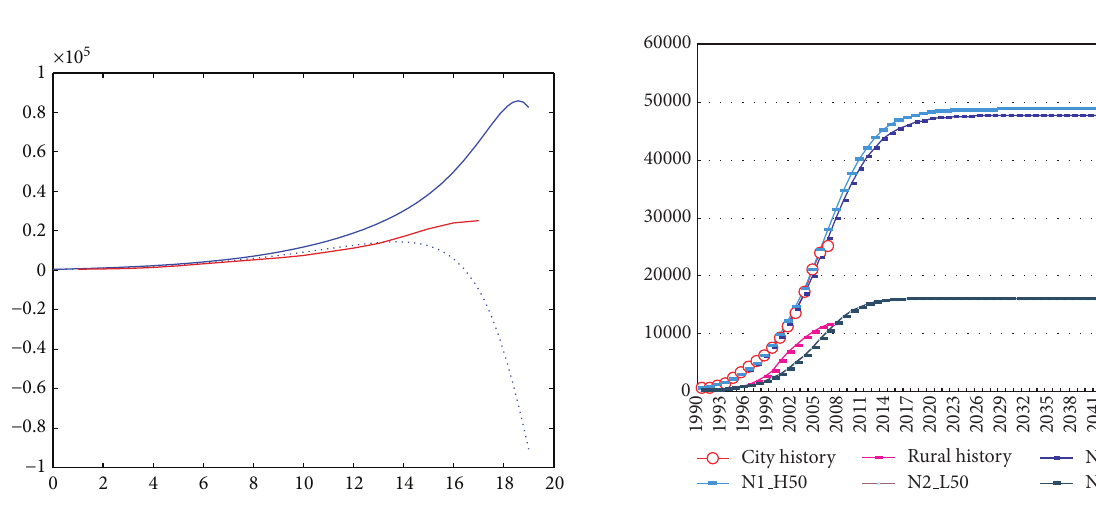
Figure 3: Plots of potential curve of telephone in urban area governed by model (67).